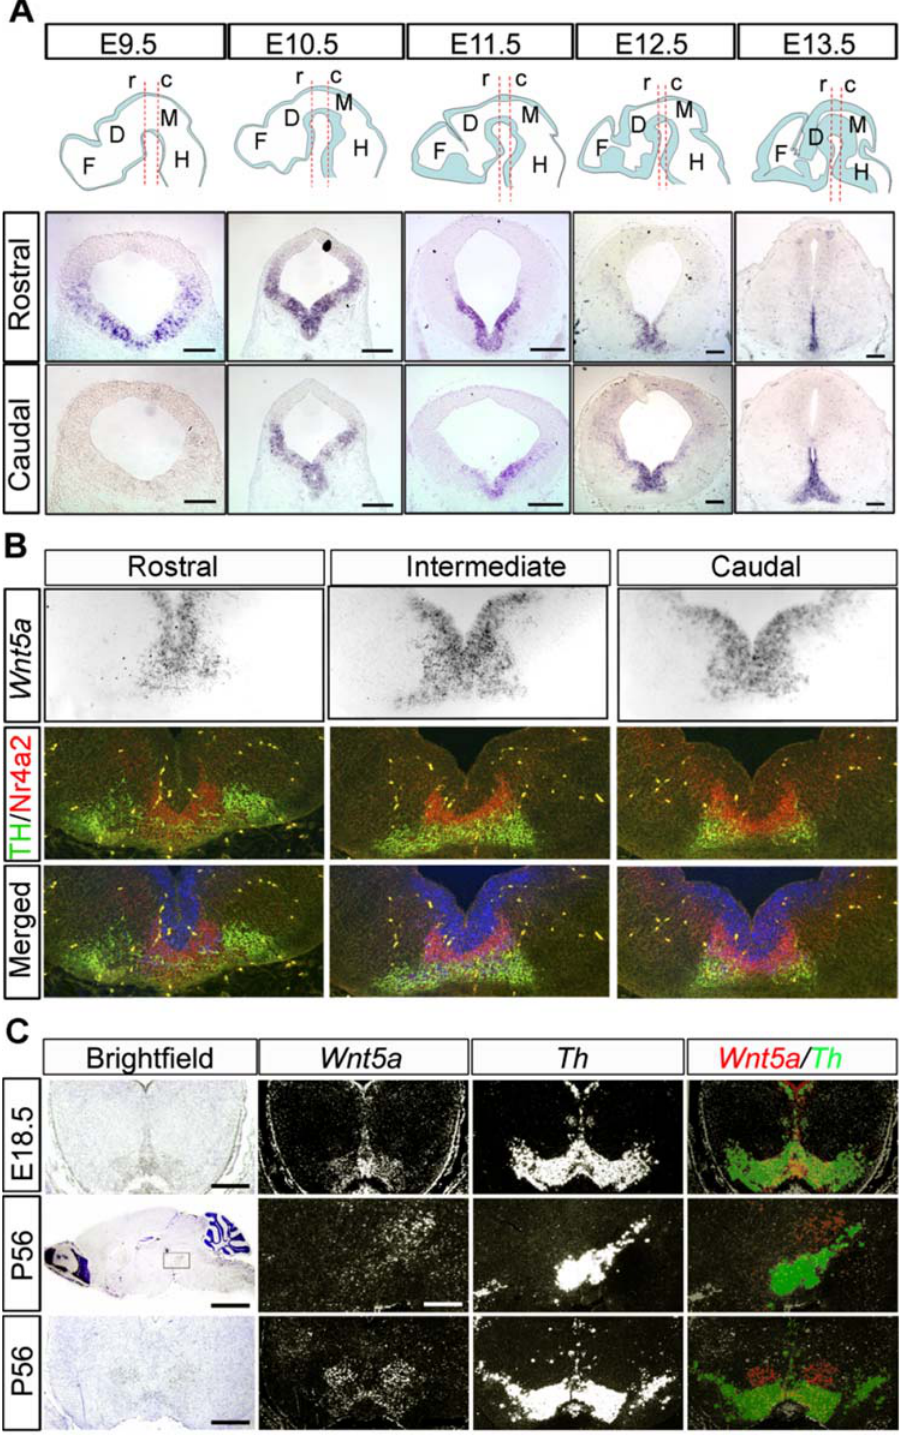
Figure 1. Temporal and spatial expression of Wnt5a in the mouse. (A) In situ hybridization for Wnt5a on coronal midbrain sections of E9.5– E13.5 CD1 mice shows a dynamic regulation of Wnt5a expression domains throughout development in both rostrocaudal distribution and developmental stages. Schemes with sagittal sections of the brain and dashed lines show the levels at which rostral (r) or caudal (c) expression analysis was performed. The expression of Wnt5a occupies the entire neuroepithelium of the ventral midbrain at E9.5 and 10.5, and becomes progressively restricted to the floor plate and basal plate ventricular zone from E11.5–E13.5, extending to the marginal zone at caudal levels (Scale bars at E9.5=100 m m, at E10.5 and E11.5=200 m m, at E12.5 and E13.5=175 m m). (B) At E12.5, the expression of Wnt5a comprises the FP extending from the ventricular zone through the intermediate zone and into the marginal zone, overlapping with NR4A2 + and TH + cells. This extension into the marginal zone is most pronounced in the caudal midbrain. (C) The expression of Wnt5a is down-regulated by E18.5, where it still overlaps with TH + cells, but 8 weeks after birth, at P56, this overlap is lost as seen in sagittal and coronal sections. (Scale bars in brightfield E18.5, coronal P56 and darkfield sagital p56=500 m m, scale bar in brightfield sagital P56=2.5 mm). Abbreviations: r=rostral, c=caudal, F=forebrain, D=diencephalon, M=midbrain, H=hindbrain. doi:10.1371/journal.pone.0003517.g001 PLoS ONE |